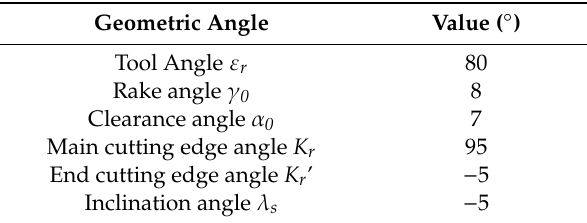
Table 1. Geometric angles of the